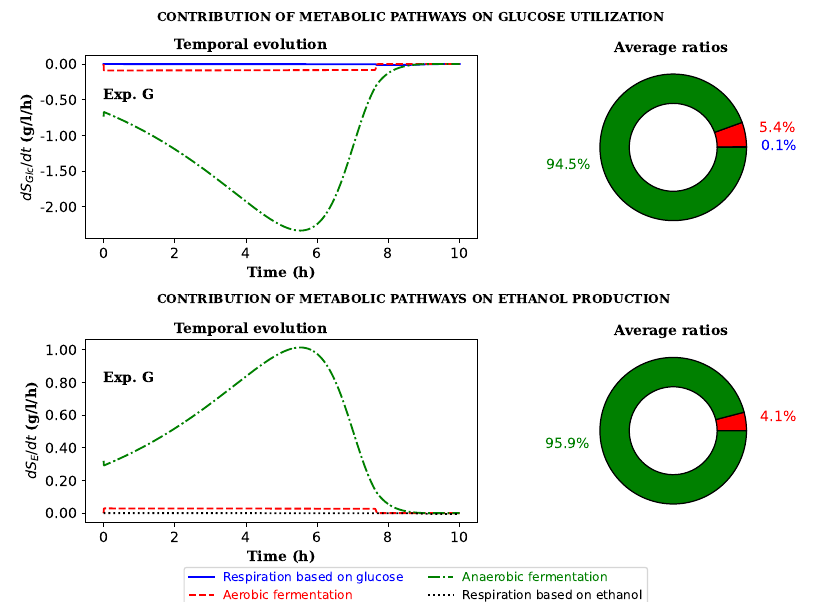
Figure 9. Contribution of individual metabolic pathways to glucose utilization and ethanol pro- duction: temporal evolution during fermentation in the absence of gas injection (line graphs) and time − average of the stoichiometric ratios (pie graphs). Ethanol consumption by respiration once glucose is depleted is not considered in the time − average of the stoichiometric ratios for ethanol production ( dS Glc /dt and dS E /dt are the glucose utilization and ethanol production and utilization rates,